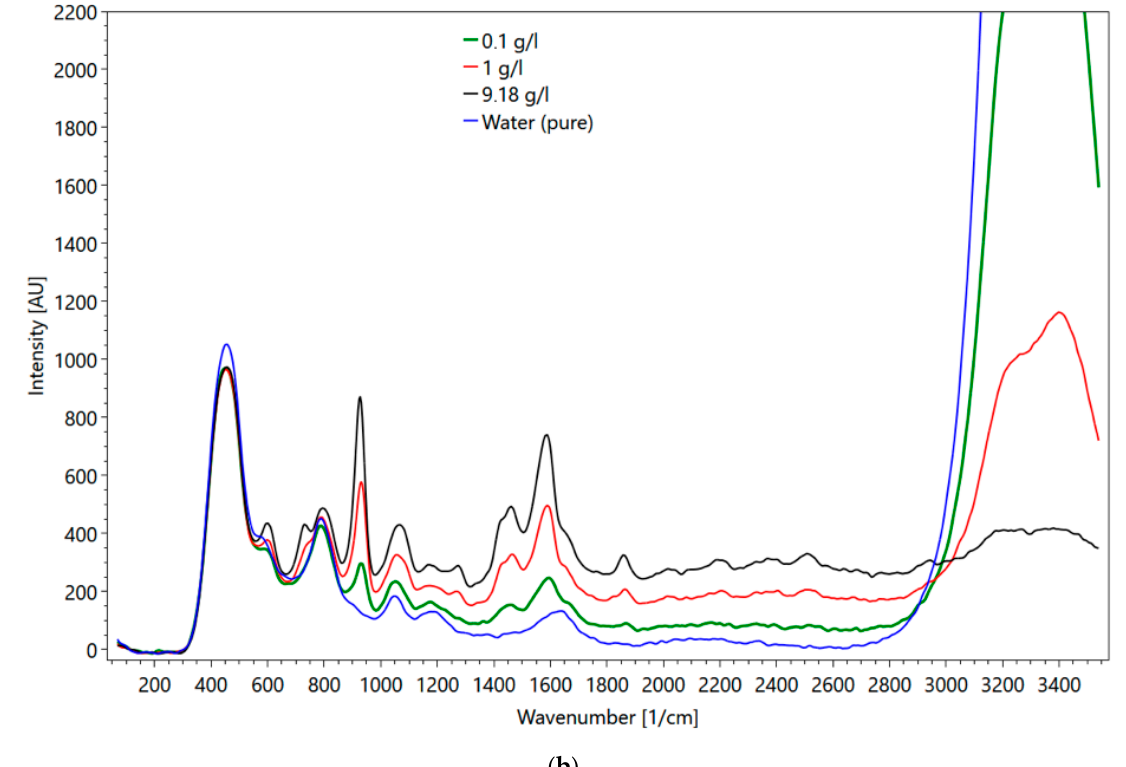
Figure 16. ( a ) Metformin hydrochloride measured in the flow cell with 0.1 (green line), 1 (red line), 9 g/l (black line) and water (blue line); ( b ) metformin hydrochloride measured in the fused silica cuvette at 9 (black line), 1 (red line), 0.1 g/l (green line) and water (blue line).